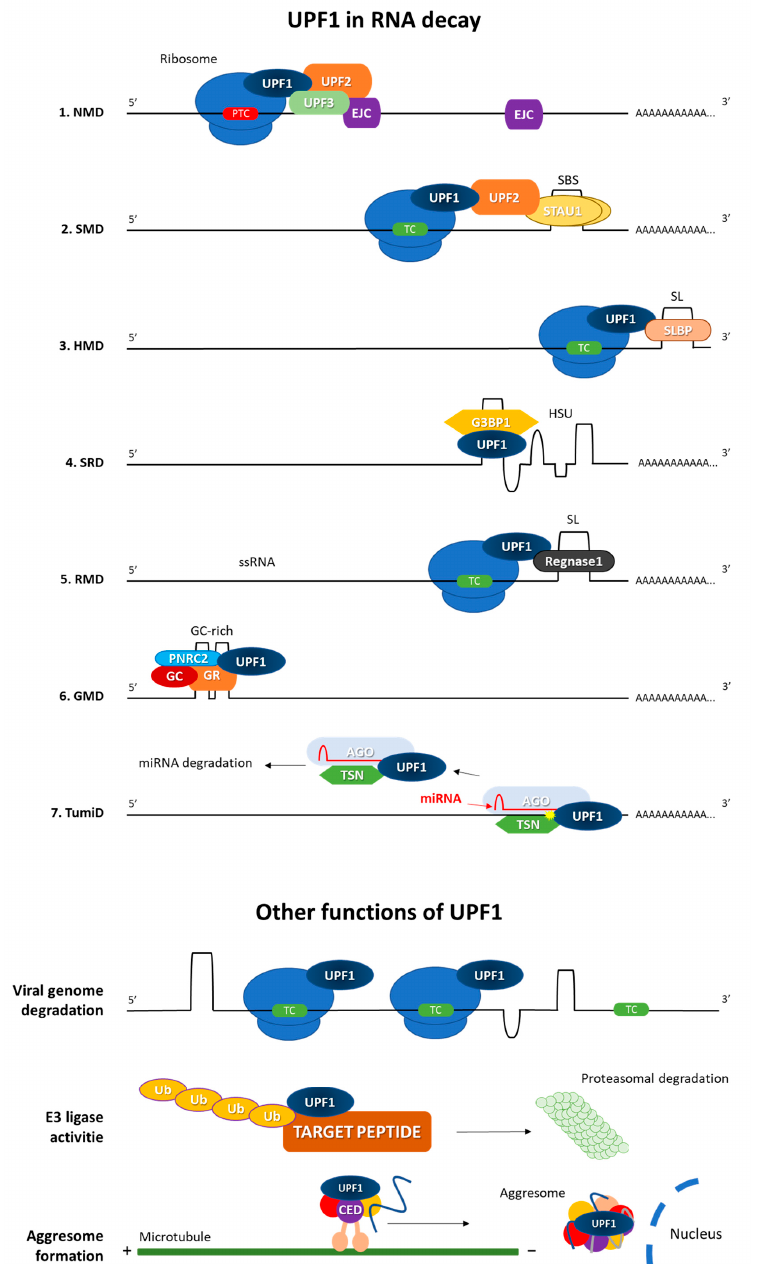
Figure 3. Selected functions of UPF1 protein: pathways of UPF1-dependent RNA decay (1–7) and UPF1 role in viral genome degradation, ubiquitination of peptides and aggresome formation. In RNA degradation, UPF1 is recruited by: (1) translation termination event on premature stop codon